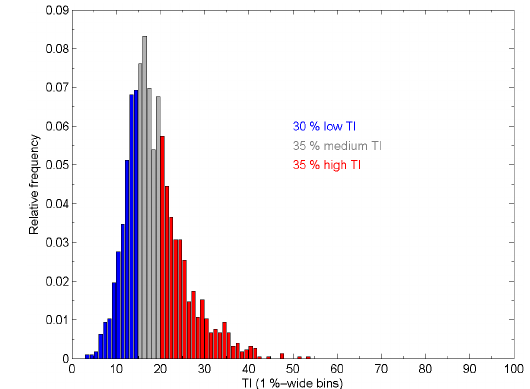
Figure 13. TI distribution using thresholds in Table 3. Includes data filtered for tower 80m wind speeds between 3.5 and 25ms − 1 , 87m wind directions between 235 and 315 ◦ , and for normal turbine op- eration.